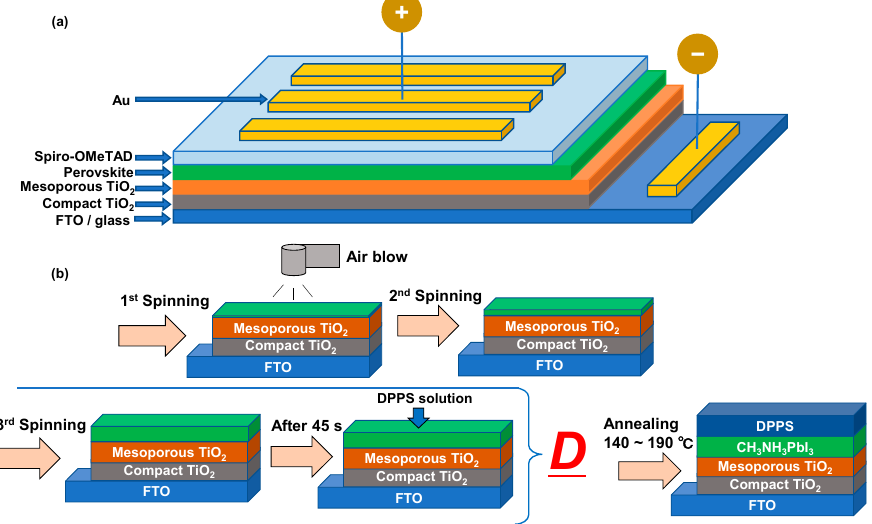
Figure 1. ( a ) Layered structure of the present solar cells (FTO/TiO 2 /perovskite/spiro-OMeTAD). ( b ) Schematic illustration of the processes to fabricate the perovskite and DPPS layers. To prepare the perovskite compounds, solutions of PbCl 2 (Sigma Aldrich, Tokyo, Japan, 111.2 mg) and CH 3 NH 3 I (Tokyo Chemical Industry, 190.8 mg) with the 1:3 molar ratio were mixed in N,N -dimethylformamide (Sigma Aldrich, 0.5 mL) at 60 ◦ C for 24